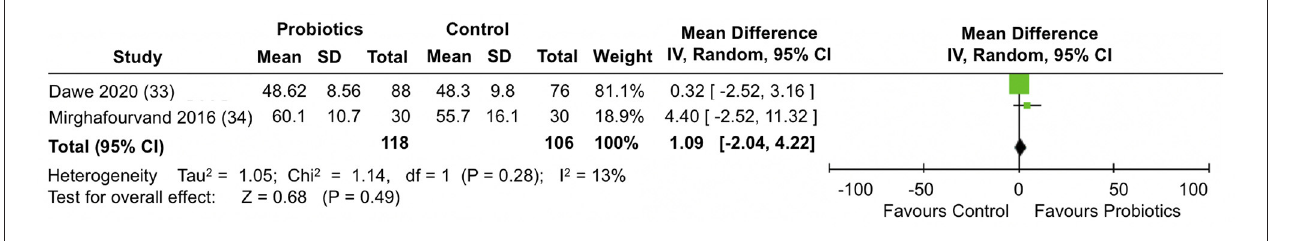
scores at the end of follow-up (MD = 1.09; 95% CI − 2.04, 4.22; I 2 =